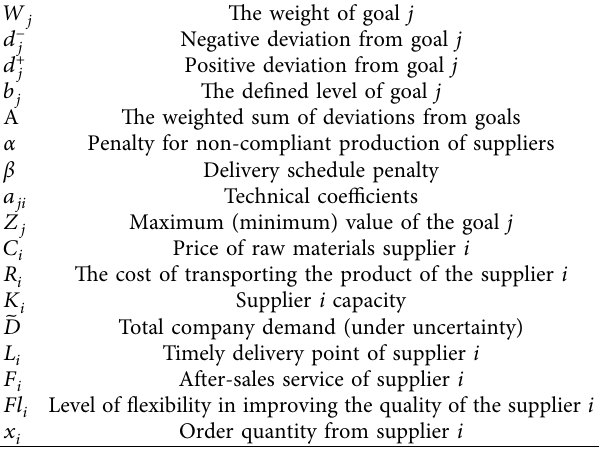
Table 3: The notation of the proposed mathematical